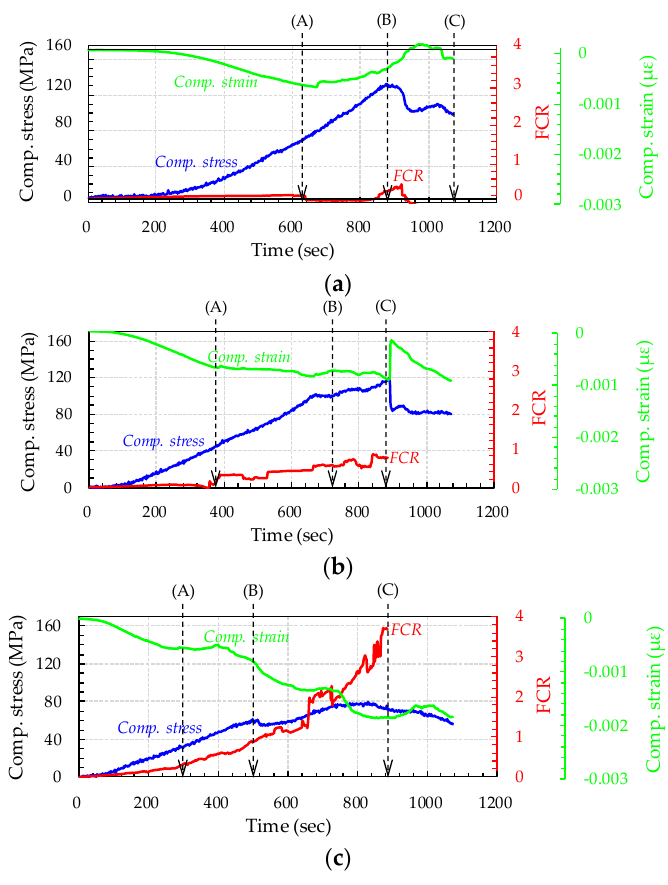
Figure 9. Compressive stress vs. time, strain vs. time, and FCR vs. time curves for UHPFRC with: ( a ) CNT 0.1%; ( b ) CNT 0.3%; and ( c ) CNT 0.5% and capital letters, (A), (B) and (C) are damage process of each specimens.